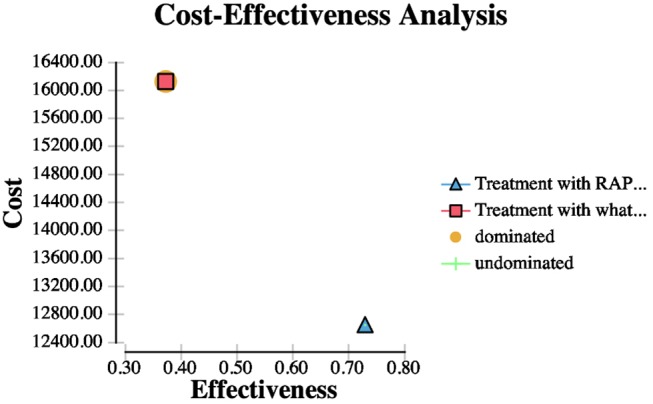
This figure demonstrates a CEA analysis curve for thrombolysis based on automated ASPECTS vs. ASPECTS interpretation on WhatsApp.